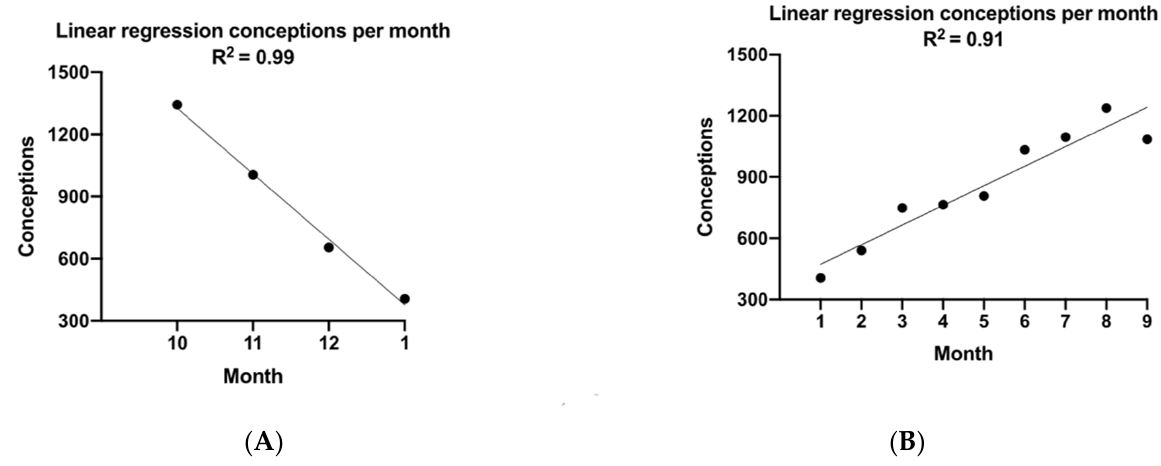
Figure 4. ( A ): Dose–response model for SO 2 on conceptions; the winter rise in atmospheric SO 2 begins in October, then peaks in January, while the corresponding monthly DICD falls linearly with the rise in SO 2 levels (R 2 = 0.99, p < 0.05). ( B ): Elimination Kinetics Model. Following the polluted winter months, atmospheric SO 2 drops to low levels by March (see Figure 3A), but the rise in conceptions (DICD) lags this steep fall in SO 2 but then recovers linearly with time (R 2 = 0.91, p < 0.05), suggesting that the negative effect of SO 2 on this population’s DICD washes out with zero-order kinetics over the summer, but returns rapidly with the onset of the following winter time pollution.